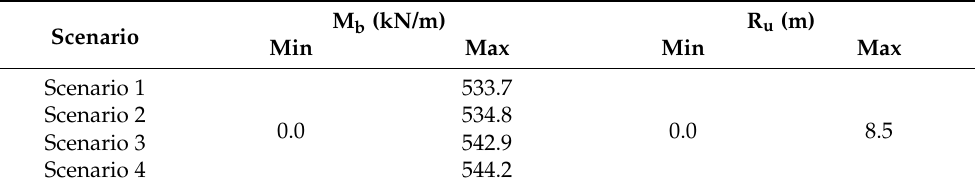
Table 8. Parameter range.